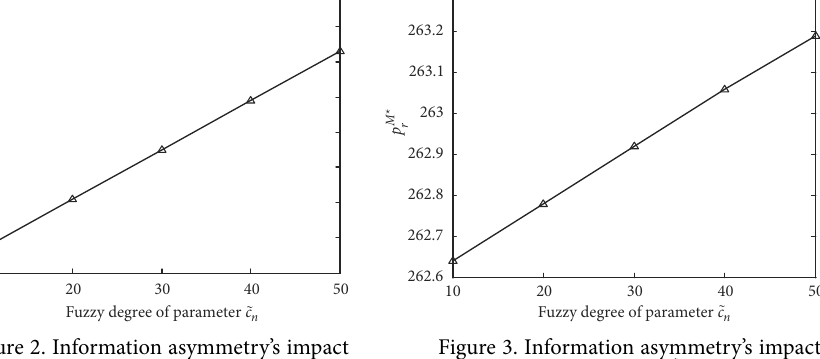
Figure 3. Information asymmetry’s impact on the